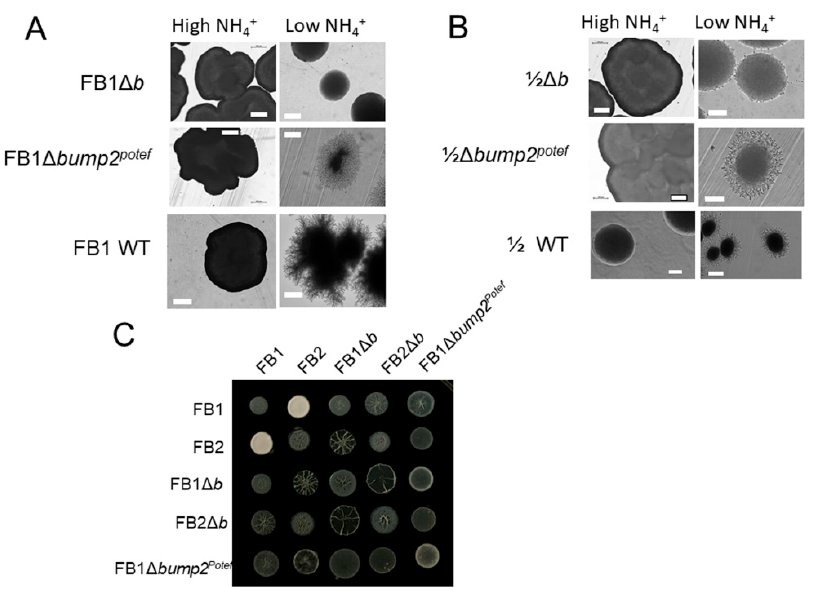
Figure 2. Phenotypes of partial b locus deletions with and without ump2 overexpression. The filamentous phenotype of haploid U. maydis colonies is lost when the entire b mating type locus is deleted in the FB1 background ( A ) as well as 1/2 background ( B ). Overexpression of ump2 in both of these backgrounds rescues the loss of filamentous phenotype. ( C ) Although the haploid phenotype is restored by overexpression of ump2 , the loss of production of aerial hyphae in a charcoal mating assay with a compatible mating partner is not restored. The ump2 overexpressor in the complete b deletion background does have a slightly fuzzy phenotype, potentially as a result of filamentation. High-NH 4 media contains 50 mM ammonium sulfate, while Low-NH 4 media contains 50 µM ammonium sulfate. Size bars, ( A ), 200 µm; ( B ), High NH 4 , 200 µm; Low-NH 4 , 100 µm.